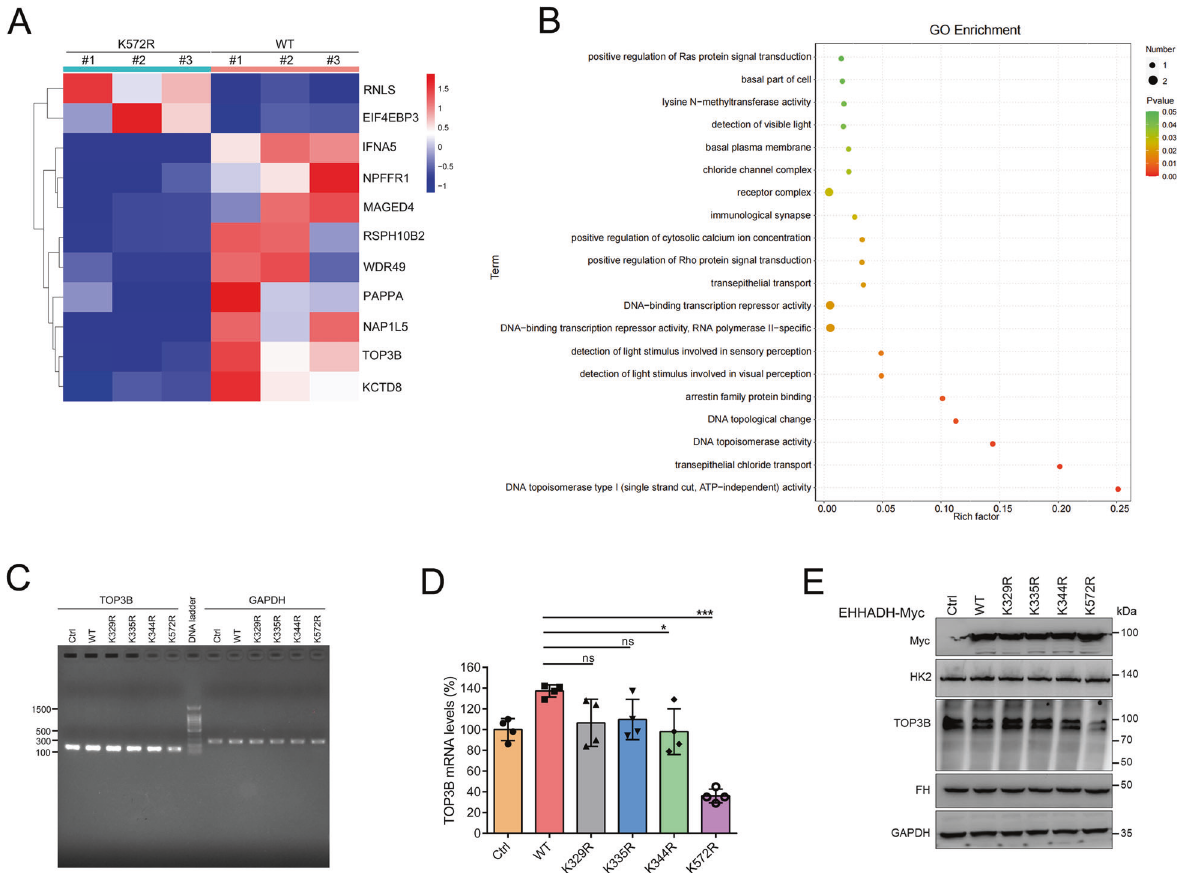
Fig. 7 Site-speci fi c regulatory role of Ehhadh K572cr on the transcriptome in vitro. A Hierarchical clustering and Heatmap showing the pro fi les of differentially expressed genes (DEGs) in 293T cells expressing Ehhadh K572R when compared with Ehhadh WT. B Gene Ontology enrichment analysis revealed that “ DNA topoisomerase type I (single strand cut. ATP-independent) activity ” was the most signi fi cantly enriched term in the K572R vs WT group. C , D mRNA levels of TOP3B were further con fi rmed by cDNA PCR ( C ) and quantitative real-time PCR ( D ). * p < 0.05; *** p < 0.001 (one-way ANOVA test, n = 4). E Western blot showed protein levels of TOP3B was downregulated whereas expression of FH and HK2 was not affected in cells overexpression K572R when compared with WT and other mutants. Representative image from three independent experiments was